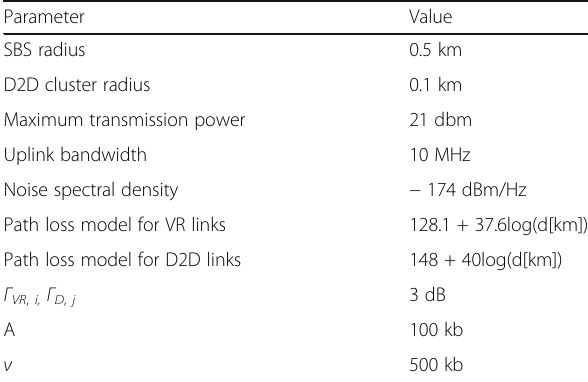
Table 2 Parameters of simulation